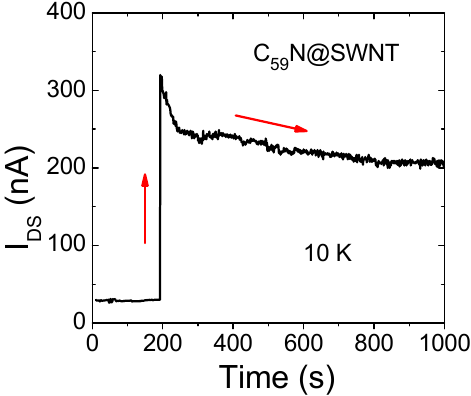
Figure 6. I measured as a function of time at 10 K under exposure of a light pulse (400 nm) DS N@SWNT-FET device with V for a C 59